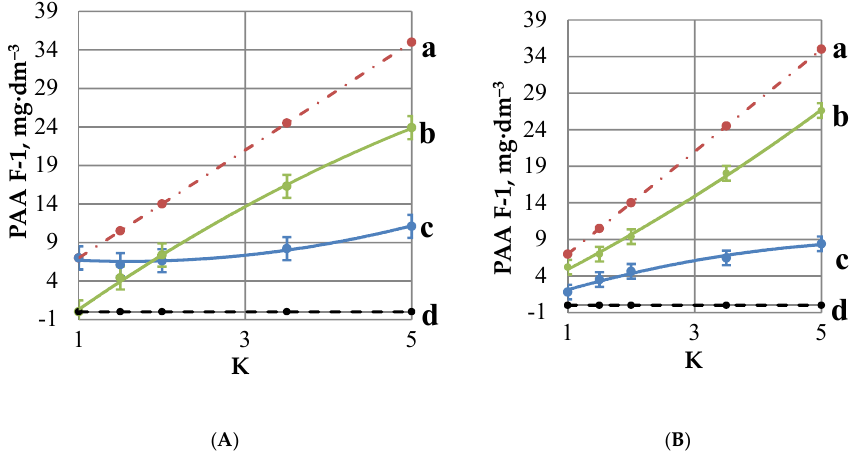
Figure 3. Variation of PAA-F1content monitored by fluorescence intensity within a Blank A ( A ) and Blank B ( B ) experiment: Total content in retentate + membrane (a), its content on membrane, expressed in units of PAA-F1 concentration in retentate (b), in retentate (c), and in permeate (d).